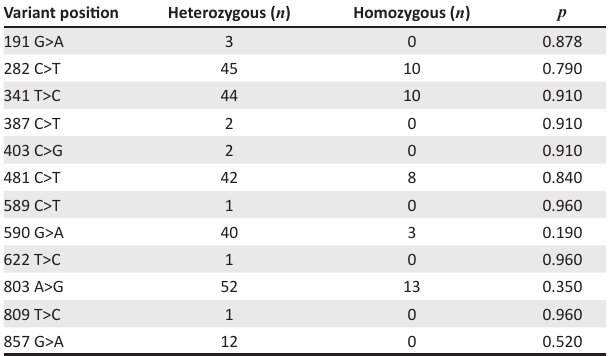
TABLE 1: Frequencies of heterozygotes and homozygotes for each observed single nucleotide variant, with associated Hardy-Weinberg equilibrium probabilities, Western Cape, South Africa,